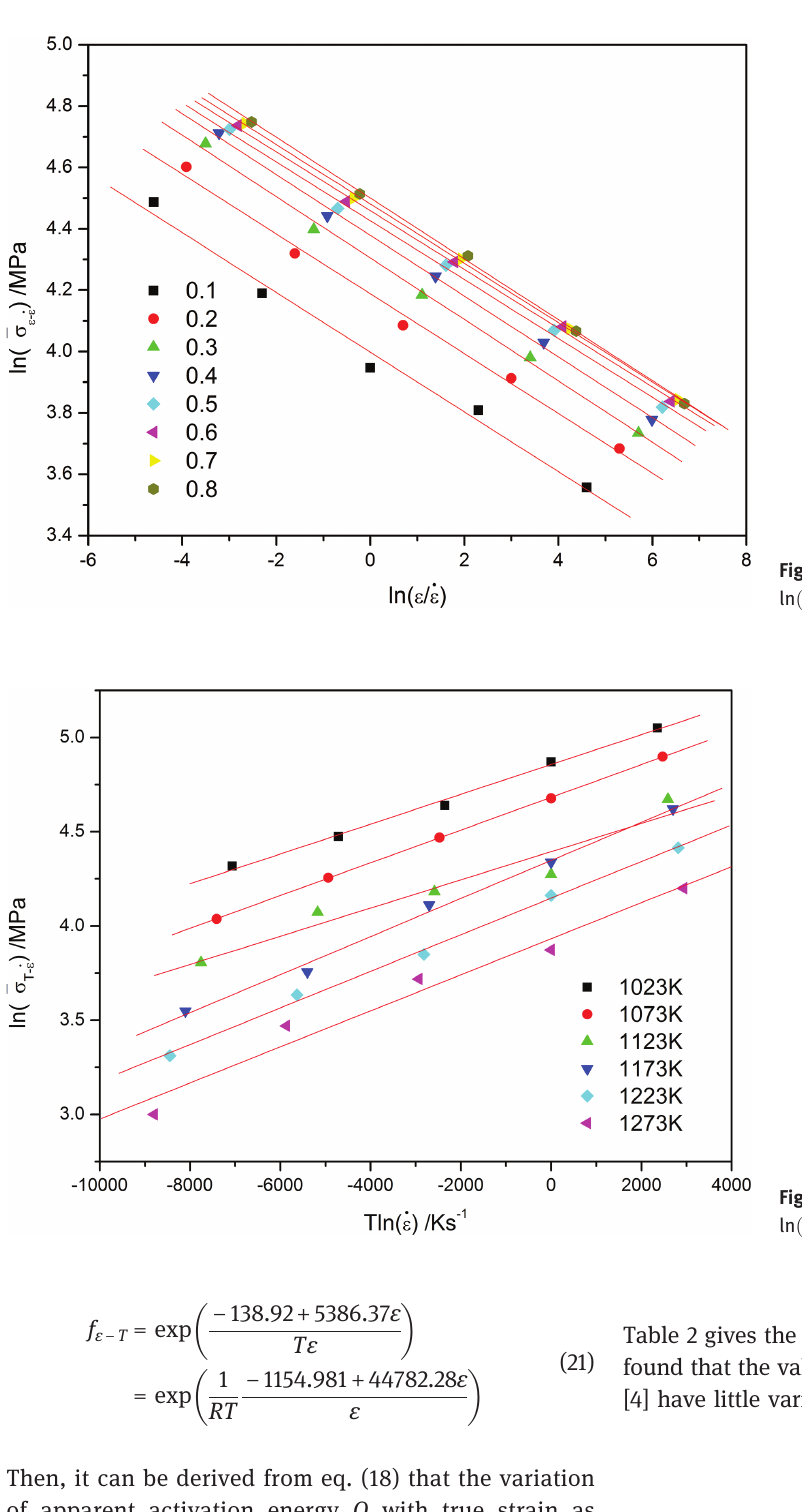
Figure 11: Relationship between ln ð (cid:2) σ _ ε − T Þ and ln ð T ln _ ε Þ